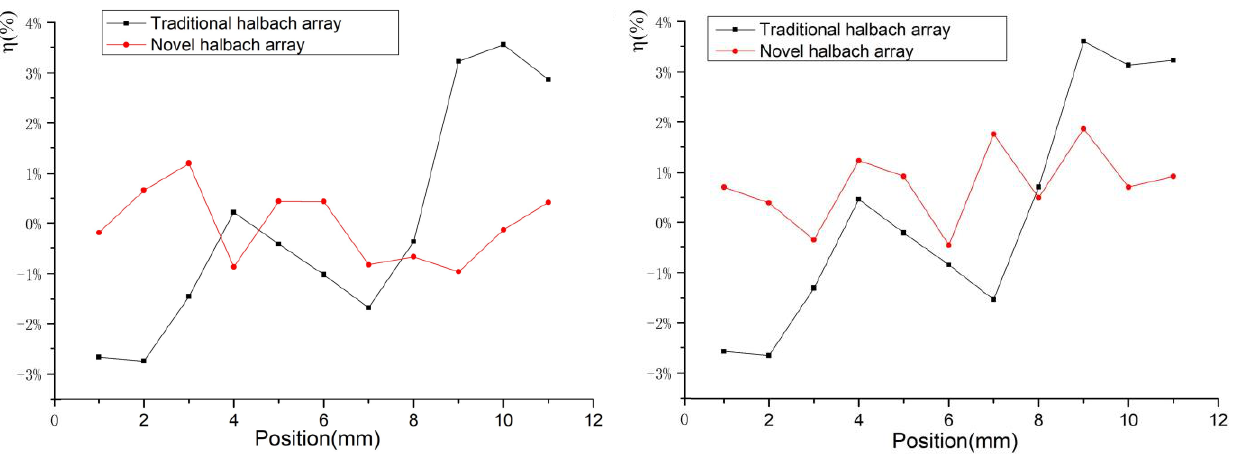
Figure 13. Ripple ratio of the driving force.